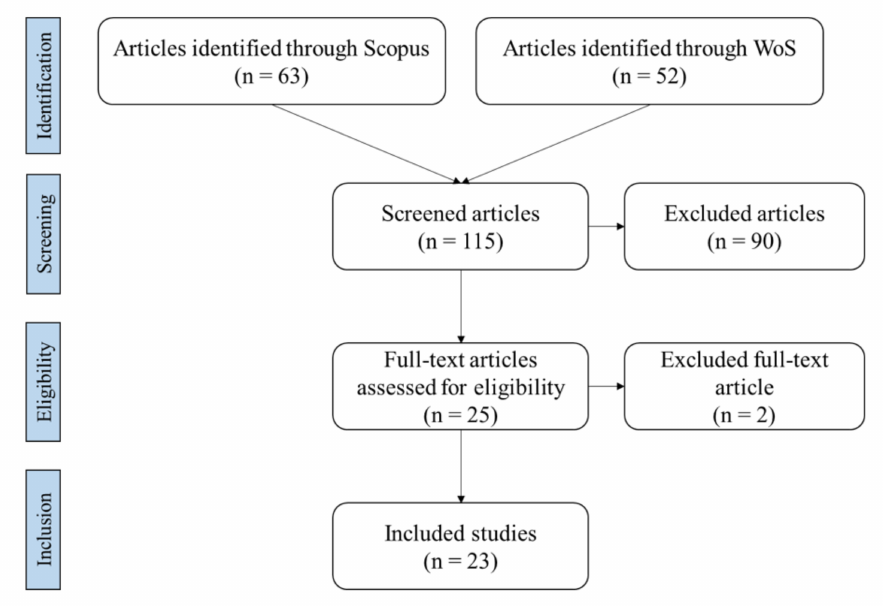
Figure 1. Process and results of the search strategy deployed in the current